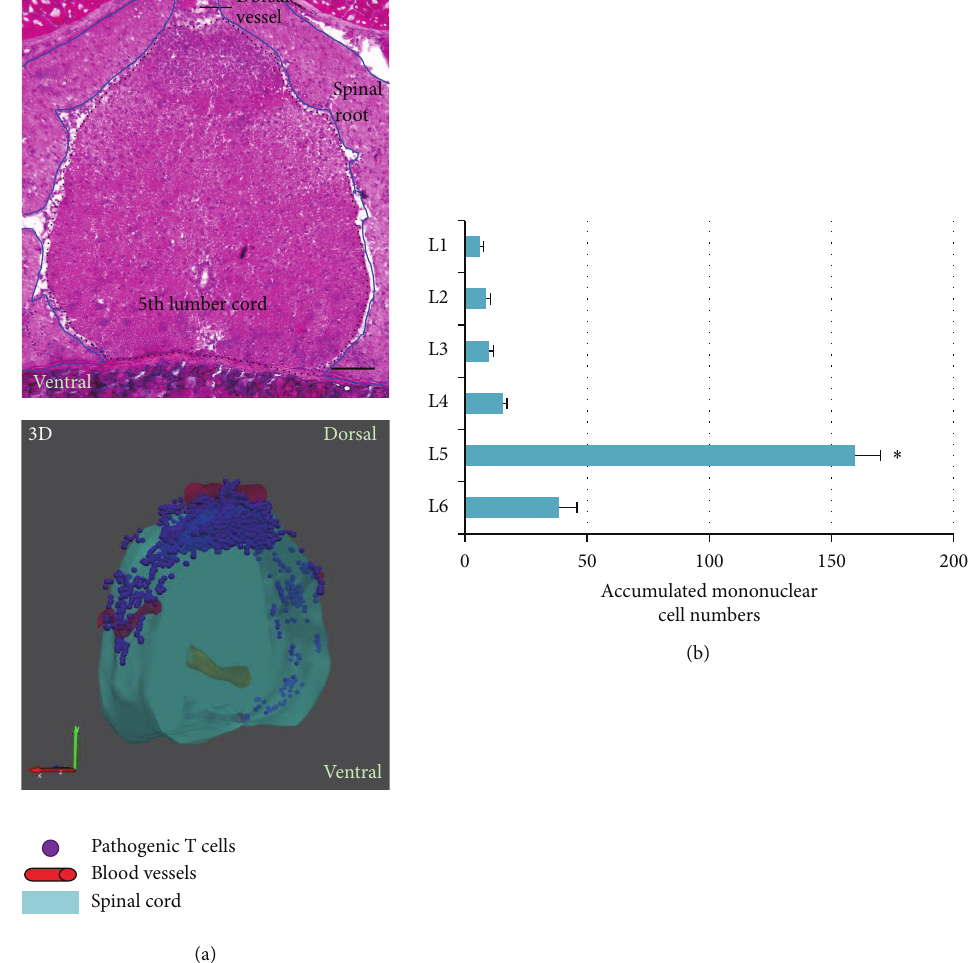
Figure 2: The fifth lumber cord is a gateway into the CNS. A cross section of the fifth lumber (L5) cord (a) and actual cell numbers of mononuclear cells accumulated in each lumber cord segment (b) at a preclinical phase of EAE (5 days after pathogenic Th17 transfer). A 3D picture based on ten serial sections of L5 is also